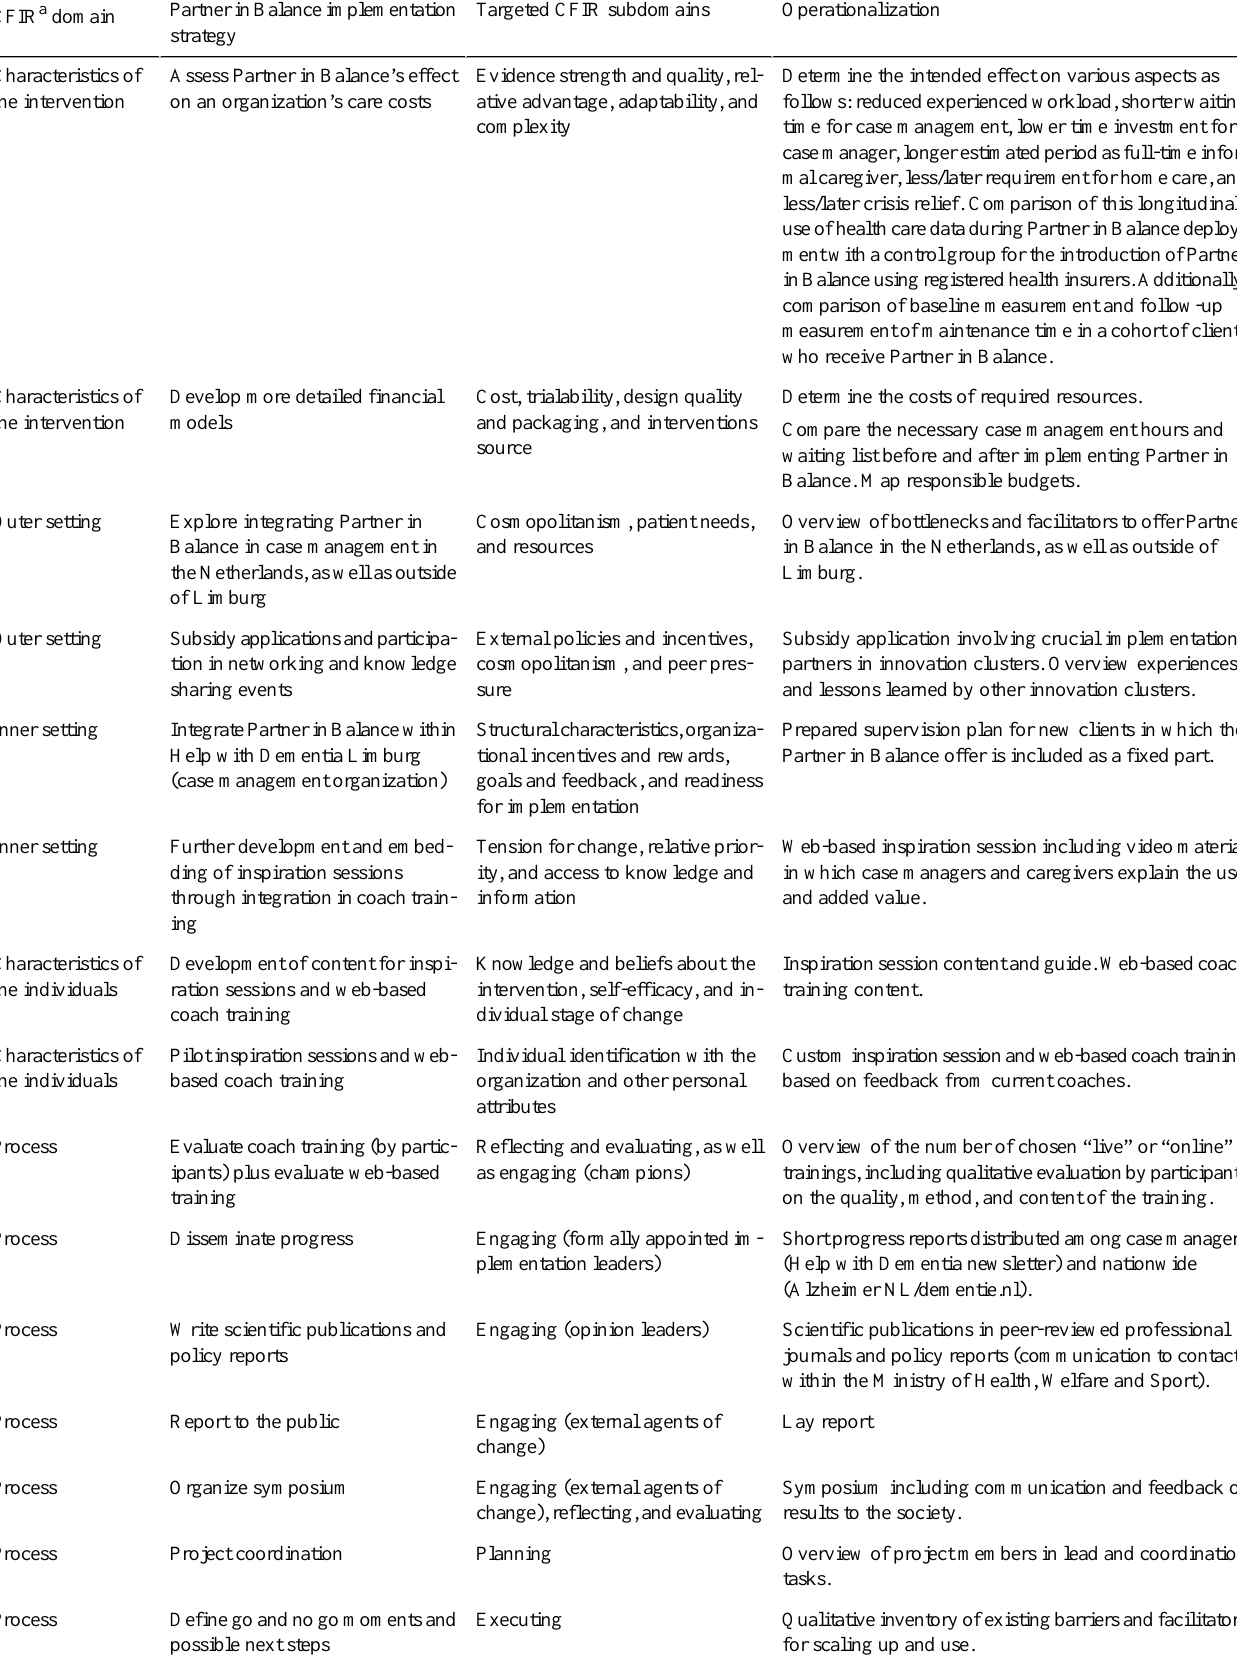
Table 3. Partner in Balance implementation strategies and consolidated framework for implementation research